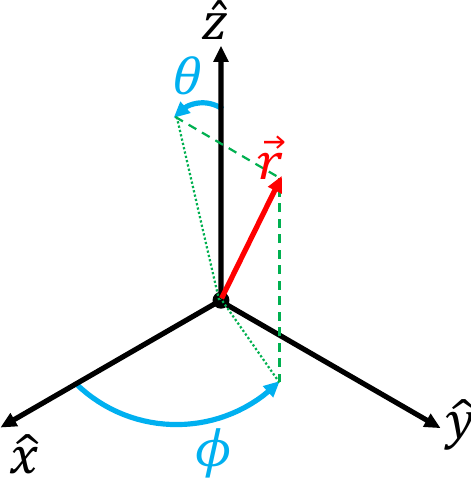
Figure 3. Representation of the spherical coordinate system used in this